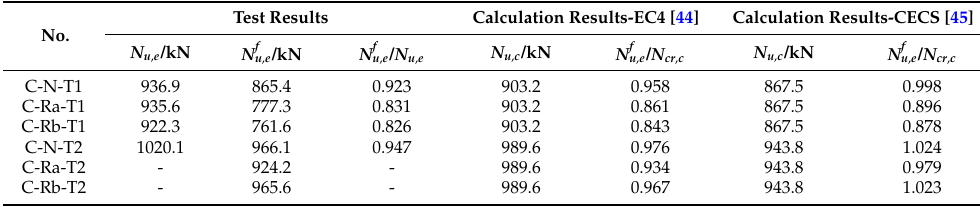
Table 7. Comparison of bearing capacities of specimens before and after